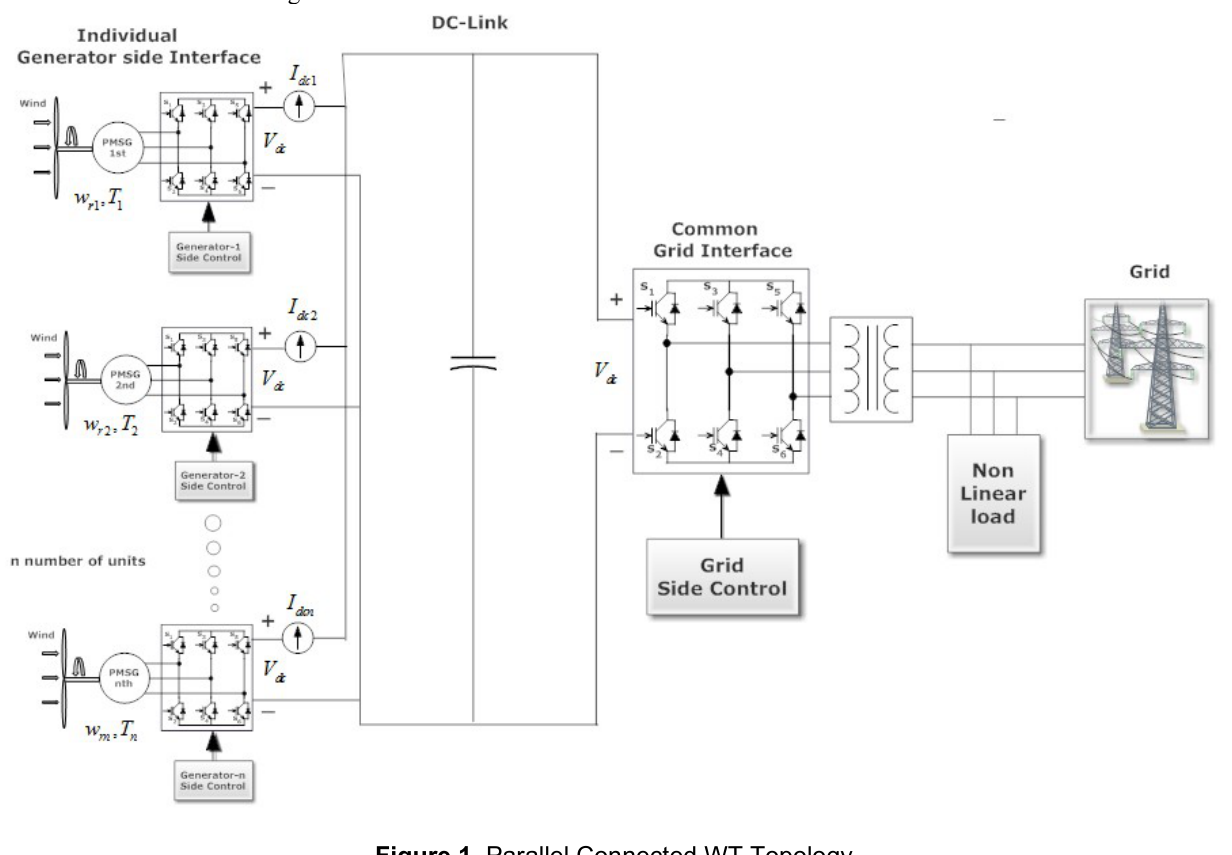
Figure 1. Parallel Connected WT